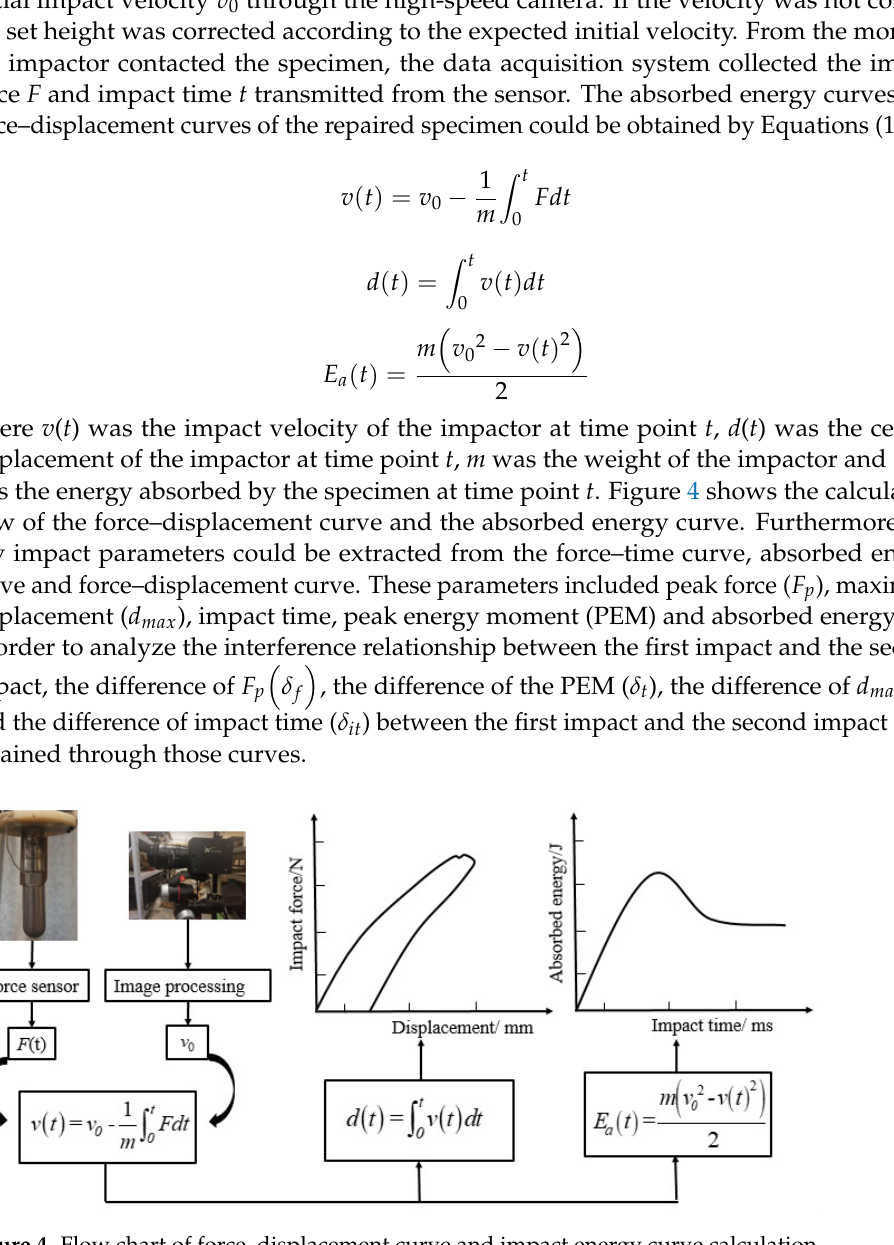
Figure 4. Flow chart of force–displacement curve and impact energy curve calculation.